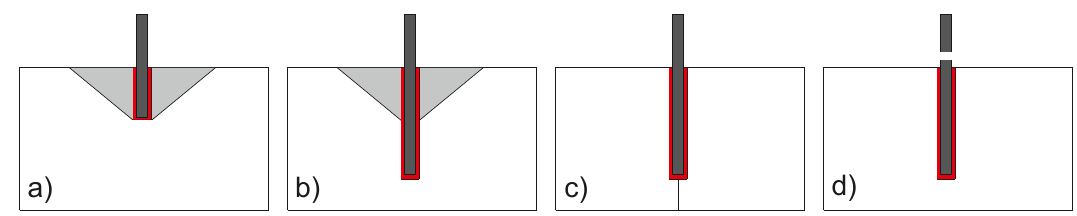
Figure 1. Possible failure mechanisms of bonded anchors: ( a ) concrete cone failure; ( b ) combined failure; ( c ) splitting failure; and ( d ) steel